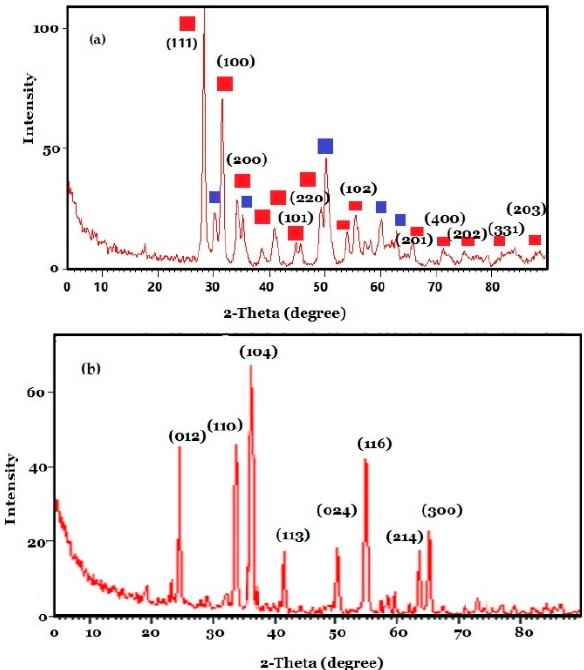
Figure 1. X-ray diffraction patterns of synthesized ( a ) ZrO 2 and ( b ) Cr 2 O 3 NPs. Figure 1. X-ray di ff raction patterns of synthesized ( a ) ZrO 2 and ( b ) Cr 2 O 3 NPs.